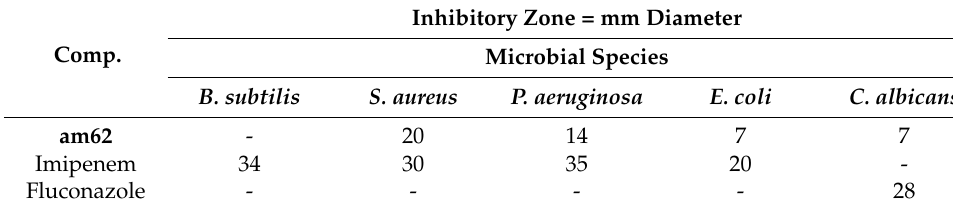
Table 29. Antimicrobial activity of the compounds ( am62 ).